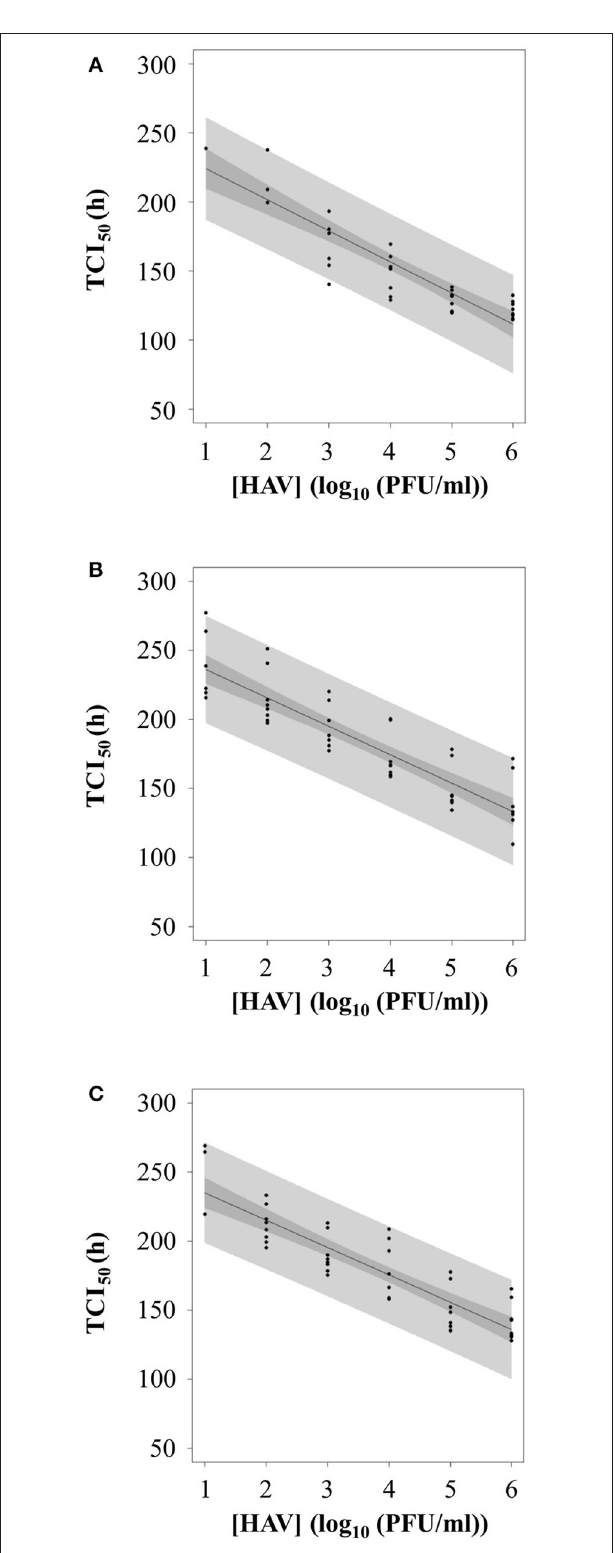
FIGURE 7 | Calibration curve between TCI 50 and log 10 of HAV concentration according to the three infection protocols: (A) Protocol 1, (B) Protocol 2, and (C) Protocol